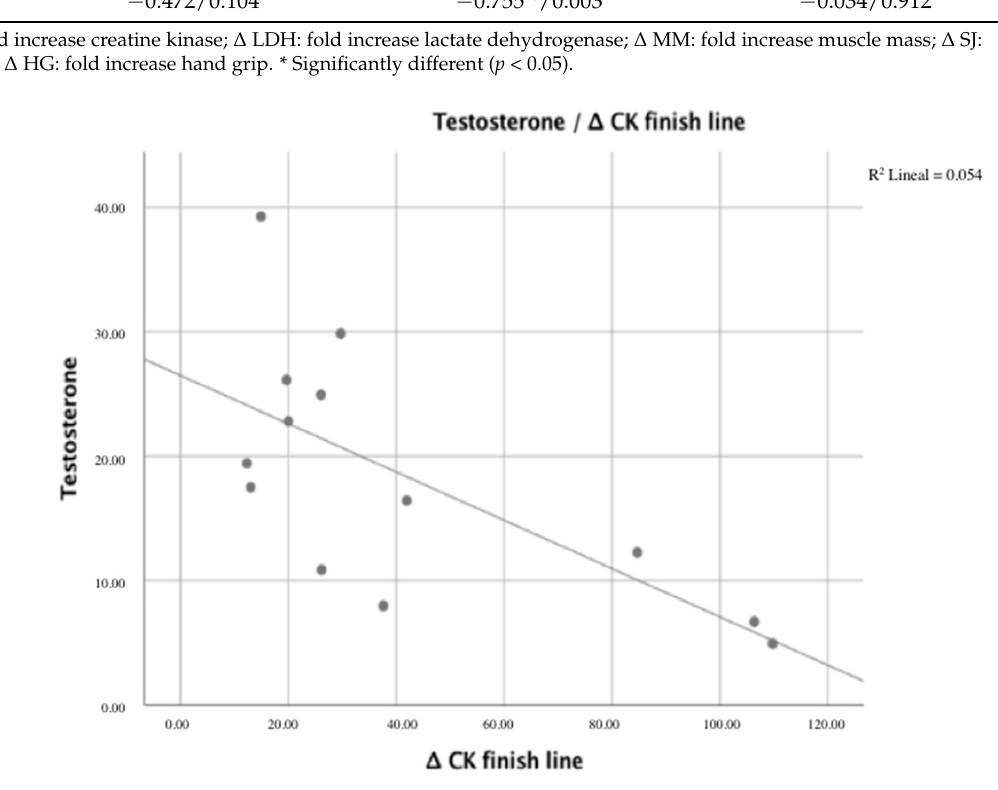
Table 2. Spearman correlations between sex hormones, muscle fatigue variables, and indirect markers of muscle damage.